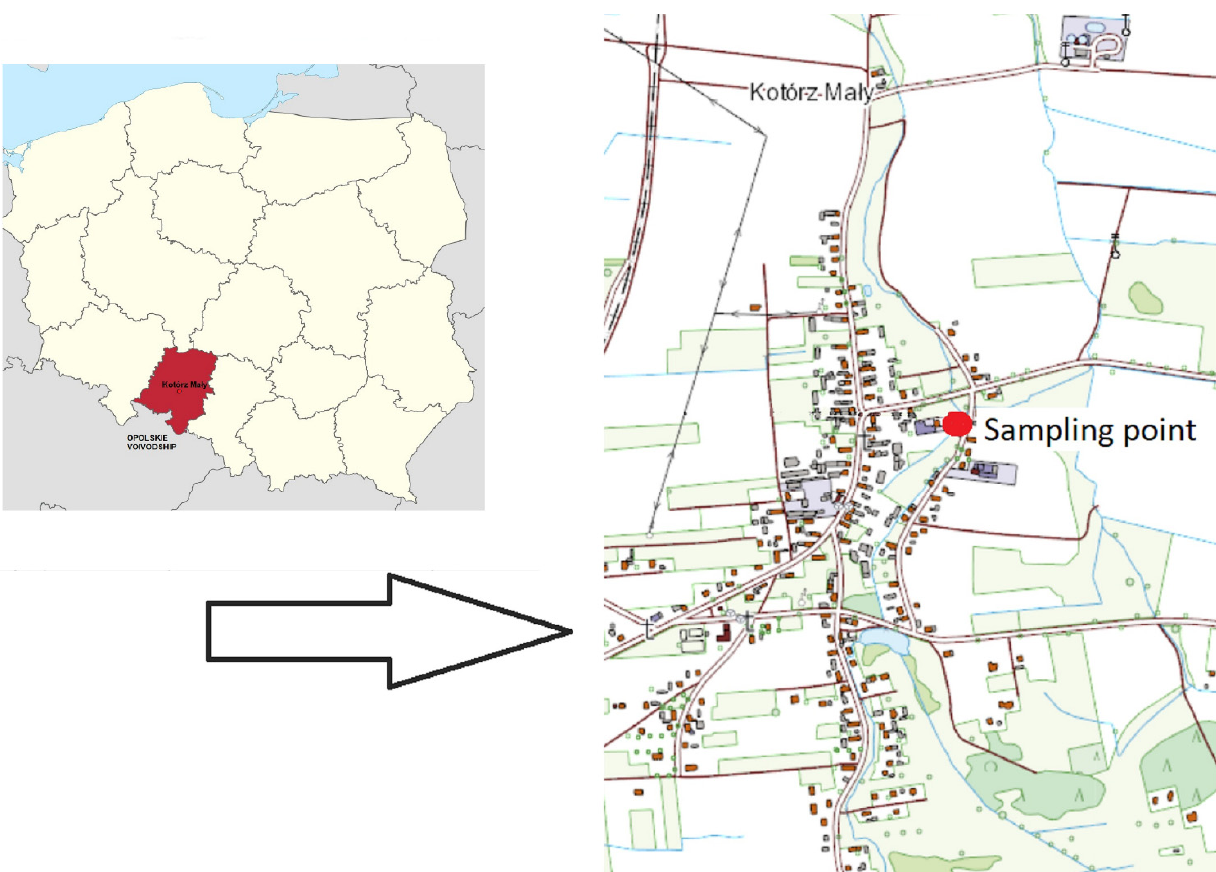
Figure 1. Location of the measuring point in Kot ó rz